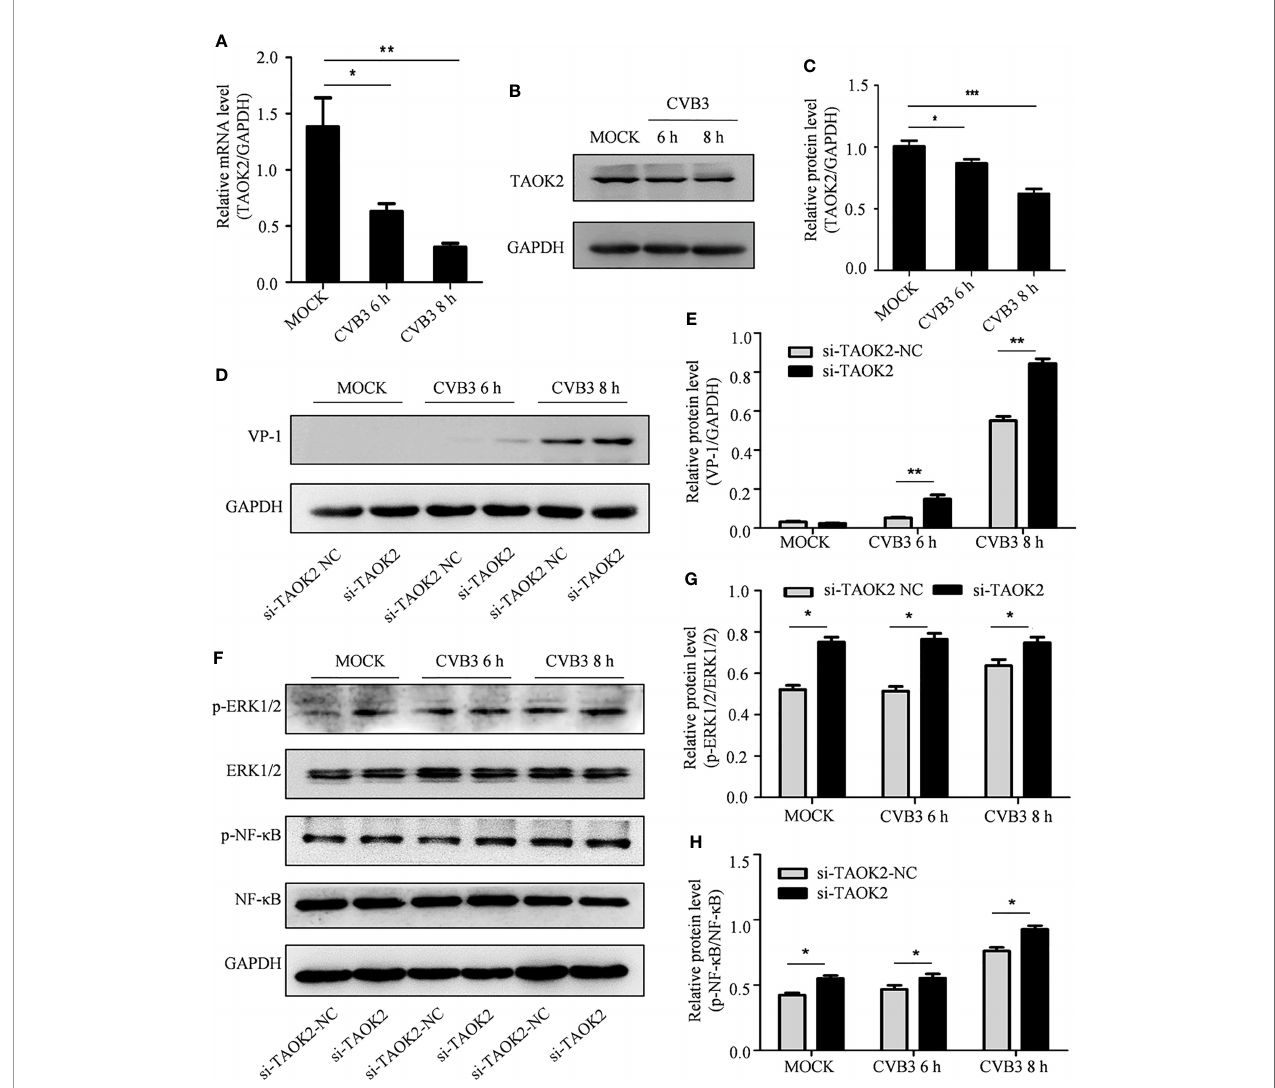
FIGURE 6 | The effect of TAOK2 on CVB3 replication. (A) Total RNA was extracted from HeLa cells infected with CVB3 for 6 and 8 h, and the relationship between TAOK2 and CVB3 was investigated by qRT-PCR. (B) Total protein was extracted from HeLa cells 6 and 8 hours post-infection with CVB3. Western blotting was used to verify the relationship between TAOK2 and CVB3. (C, E, G, H) Same as Figures 2C, H . (D) Total protein of si-TAOK2-transfected cells infected with CVB3 at 6 and 8 h was extracted, and the relationship between TAOK2 and VP-1 was veri fi ed by Western blotting. (F) Total protein was extracted from si-TAOK2 transfected HeLa cells following for 6 and 8 h of infection with CVB3. The levels of p-ERK1/2, ERK1/2, p-NF- k B and NF- k B were detected by Western blot. *p < 0.05, **p < 0.01, ***p <